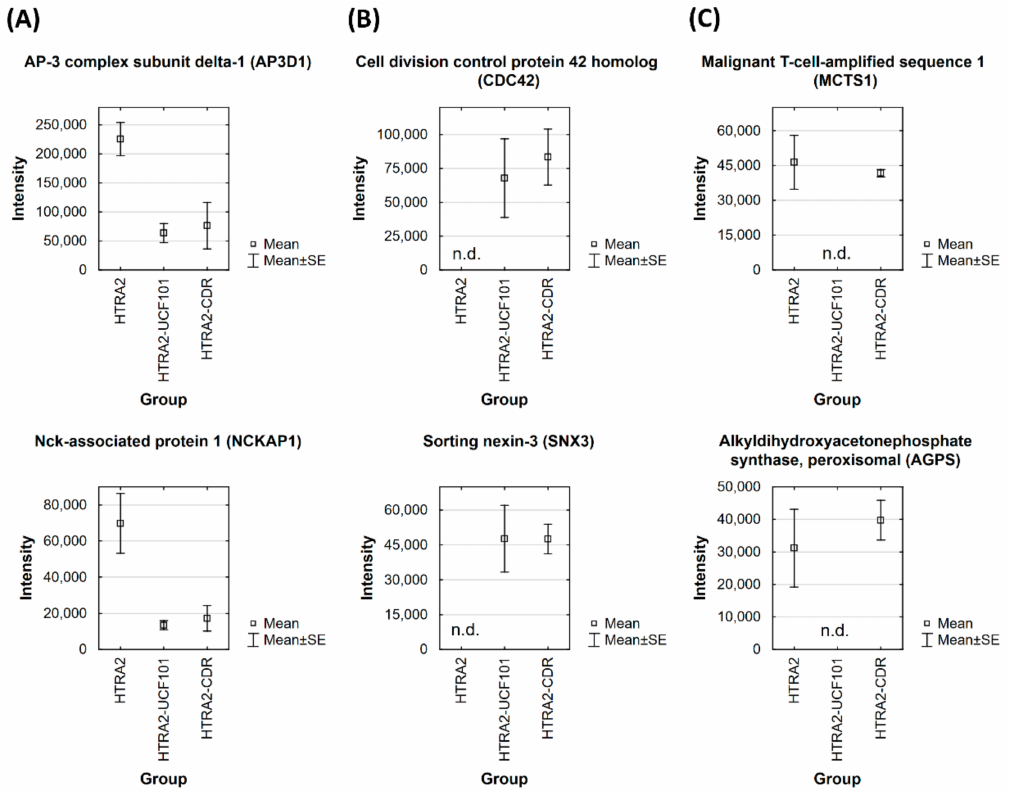
Figure 3. Bar plots of exemplary protein interaction partners enriched with recombinant 6xHis-tag HTRA2 ± 10 µ g UCF-101 or 10 µ g synthetic CDR peptide. ( A ) Bar plots on the left show significant HTRA2-specific interaction partners AP3D1 and NCKAP1, which were diminished by additional treatment with UCF-101 or synthetic CDR peptides. ( B ) Bar plots in the middle represent protein interactors CDC42 and SNX3, which were specifically enriched in samples with 6xHis-tag HTRA2 ± UCF-101 or synthetic CDR peptides. ( C ) Bar plots on the right indicate the enrichment of HTRA2-specific protein interaction partners MCTS1 and AGPS, which were specifically suppressed by the treatment with UCF-101. All of the protein interactors of HTRA2 were significantly enriched compared with the control bead group ( p < 0.01; log 2 fold change > 1.5). Not detectable (n.d.) proteins were not present in at least three biological replicates of the respective group (HTRA2, UCF-101, or CDR